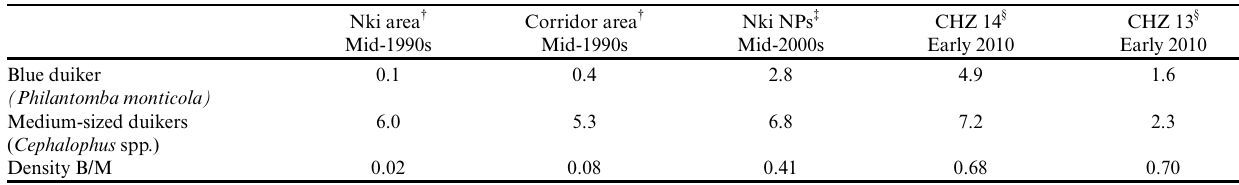
Table 7 . Density estimations of blue and medium-sized duikers and density B/M in Nki NPs and and CHZs 14 and